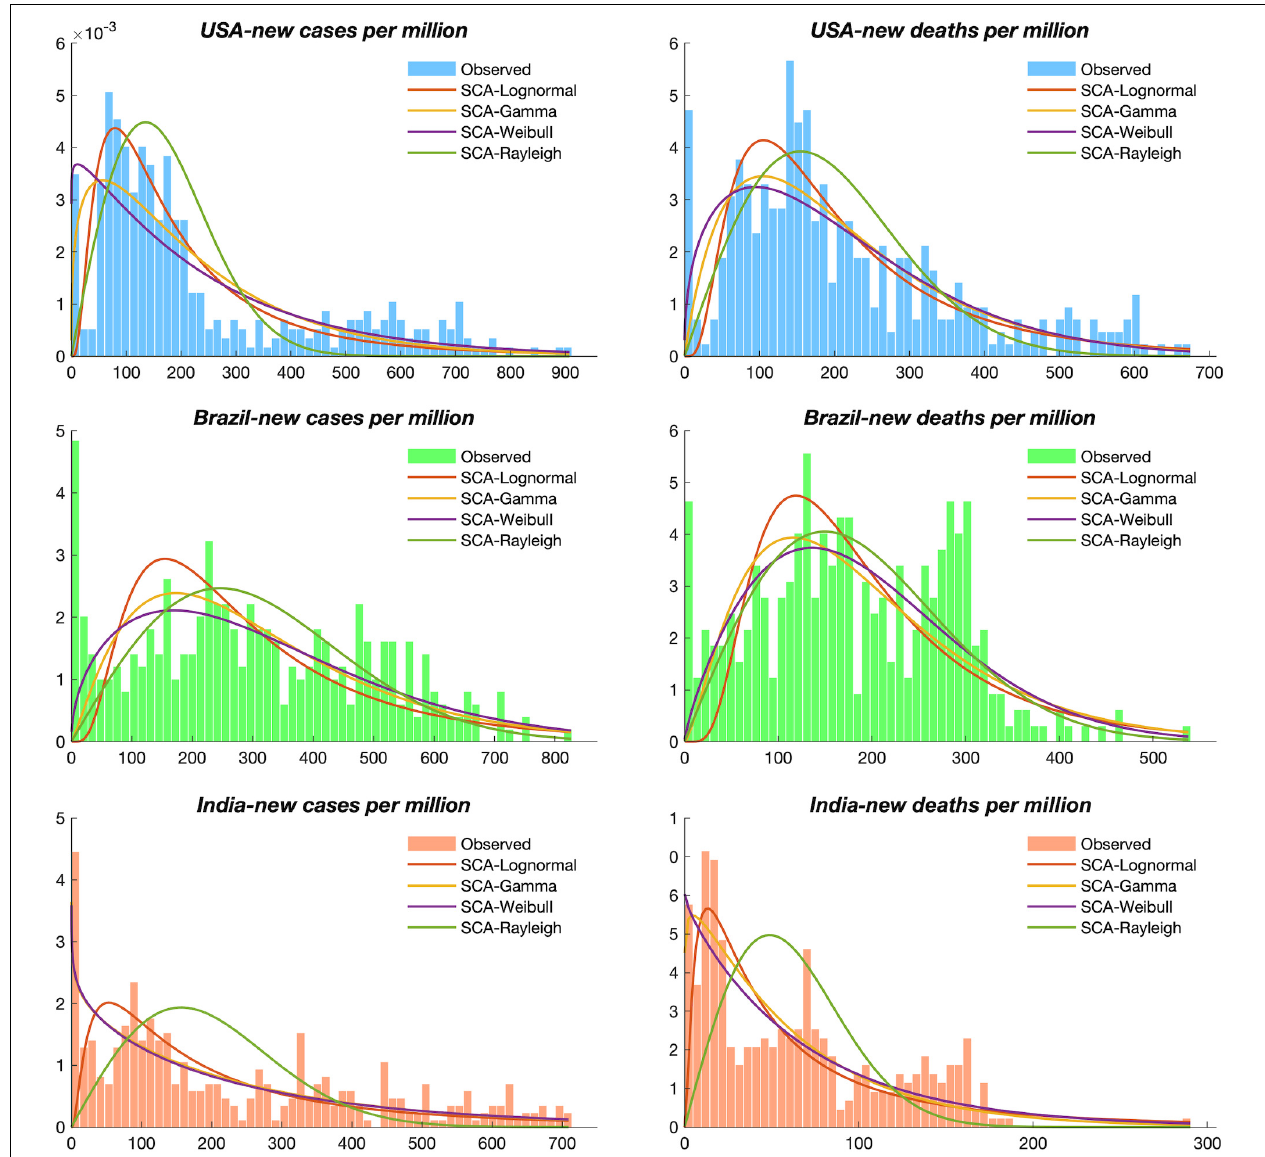
FIGURE 2 | The observed sequences and probability density functions of four distributions in the United States, Brazil, and